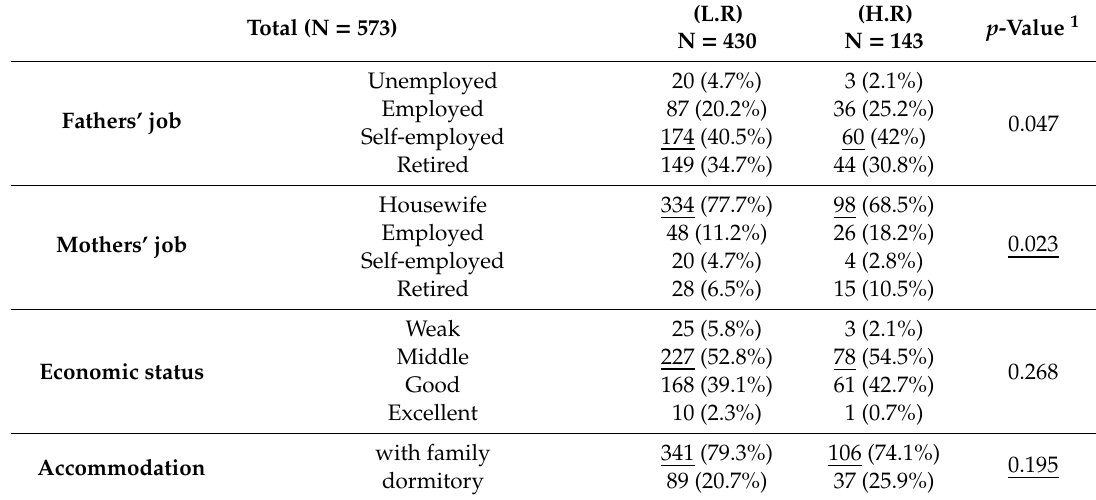
Table A1. Further demographic characteristics in frequency